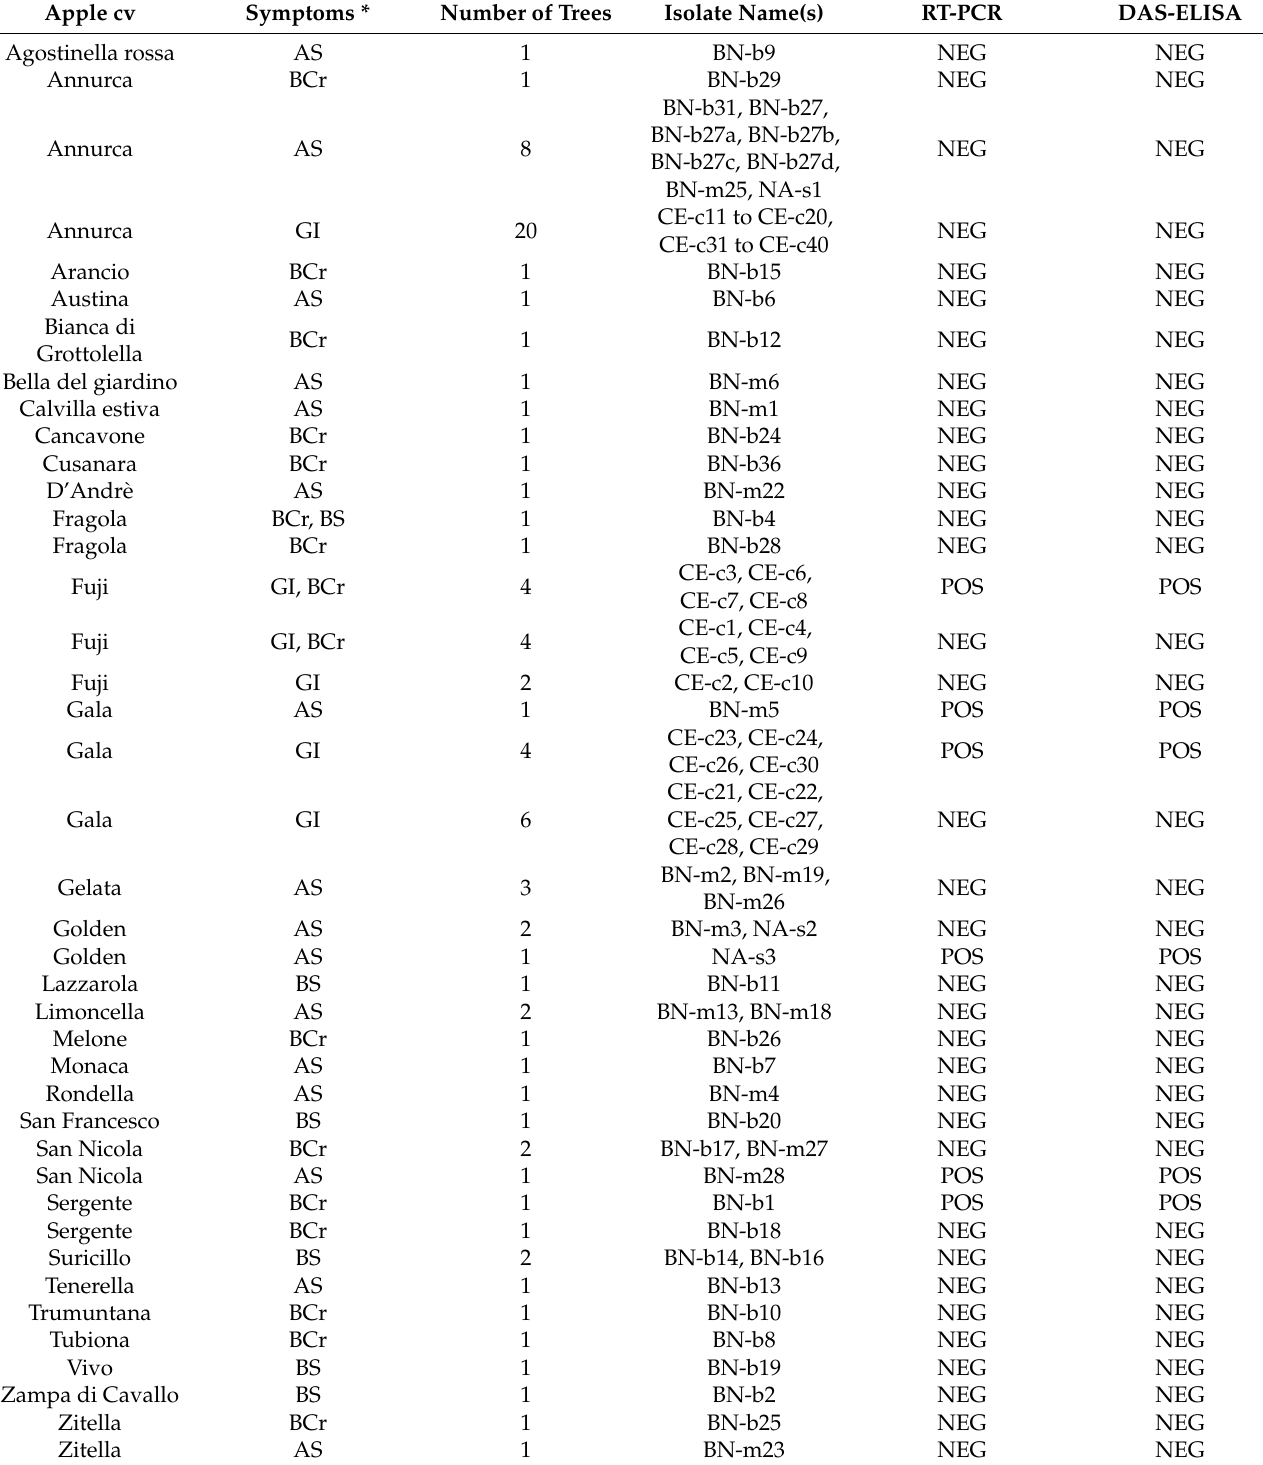
Table 2. Field survey of CCGaV in apple using RT-PCR and